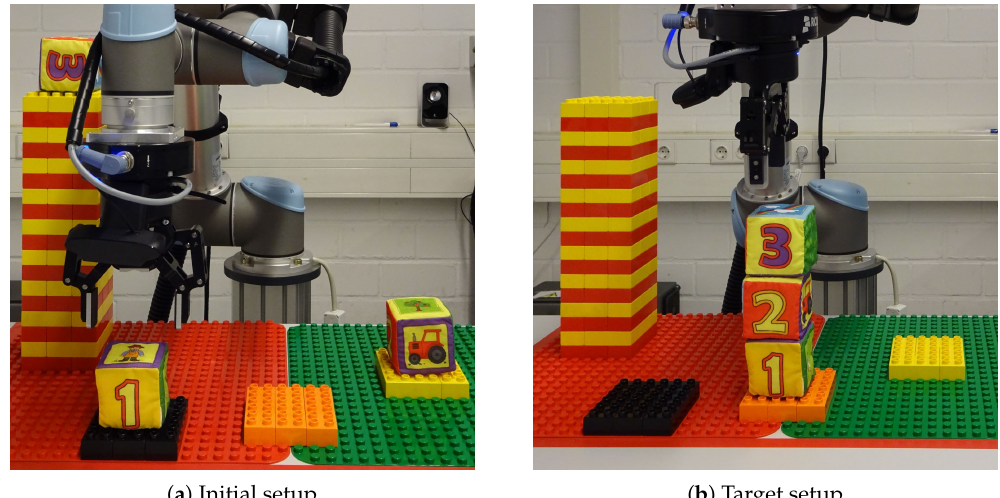
Figure 10. Experimental setup of the complex task. The users had to find their own control strategy to solve the